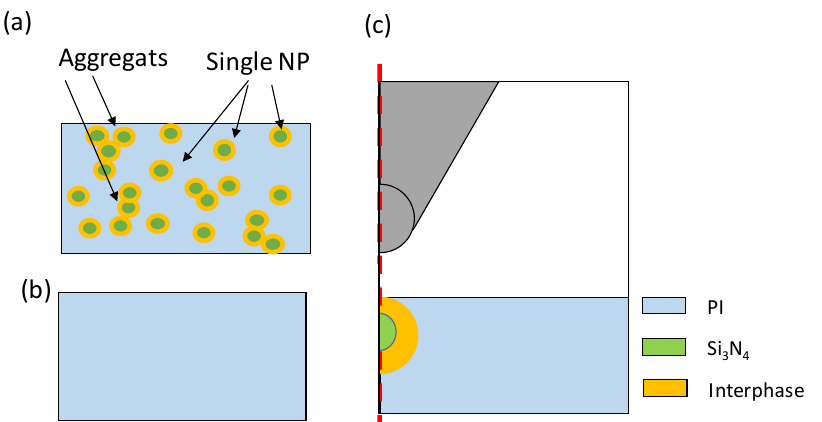
Figure 1. Graphical representation of the: ( a ) nanocomposite and ( b ) bare polyimide (PI) layers. ( c ) Scheme of the 2D-axisymetric FEM model developed for static dielectric permittivity determination from EFM measurements.